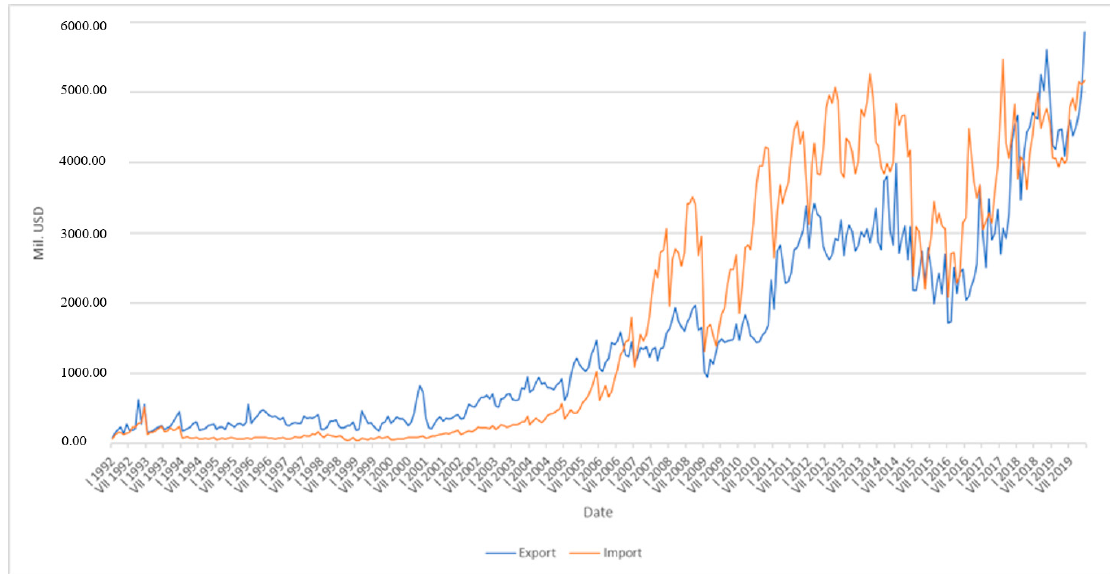
Figure 1. Development of RF and PRC export and import between January 2000 and July 2019 (from the point of view of RF); Note: The values in the entire text are given in USD million (Source: International Monetary Fund